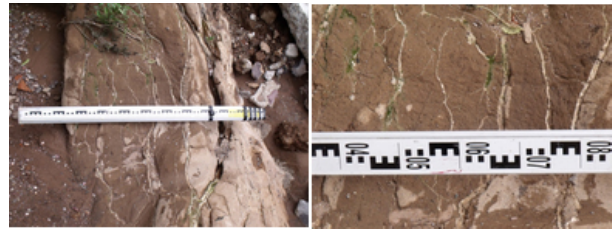
Figure 4. Filled cracks inside the zone of influence of the Ori- ente Fault. Refill consisted in groundwater caliche with a maximum thickness of 1cm.